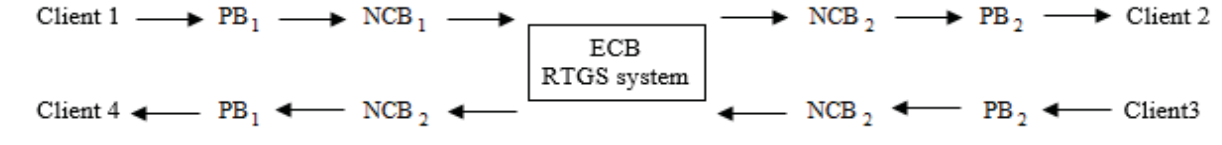
Fig. 1. Schematic representation of the reformed system of cross-border payments